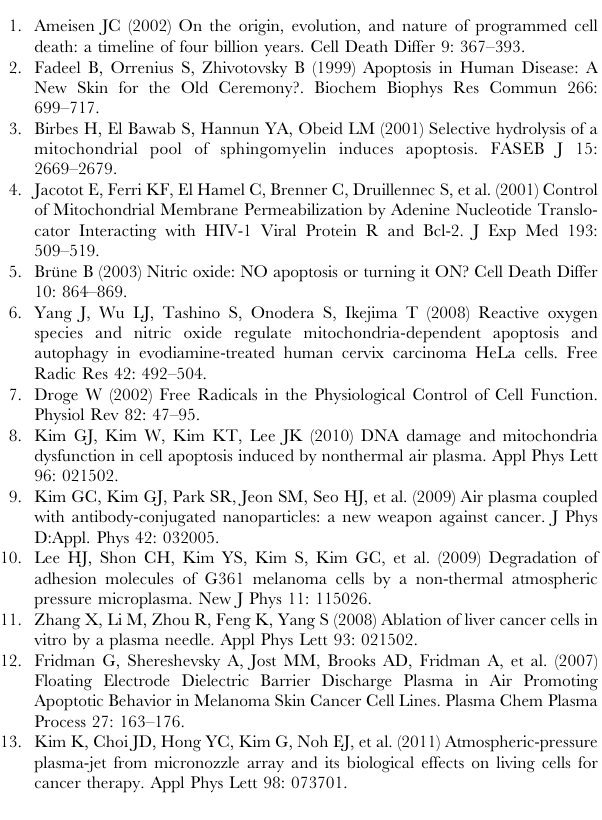
Figure S4 Antioxidants are able to alleviate the apo- ptotic effect induced by N 2 and air plasma exposure. Cells were treated with D-Mannitol (D-Mann), sodium pyruvate (S Py), carboxyl-PTIO (C-PTIO) or N-Acetyl-cystein (NAC), 1 hr prior to treatment with an air and N 2 plasma jet. Cells were exposed to the air and N 2 plasma jet, immediately after treatment with caspase 3 or 9 inhibitor. Cells were treated with N 2 or air plasma jets for 5 min and then incubated further for 24 hr. After harvesting, cells were stained with anti-annexin V-FITC and PI and analysed by flow cytometry. Population (%) of apoptotic and necrotic cells are shown (bottom table).